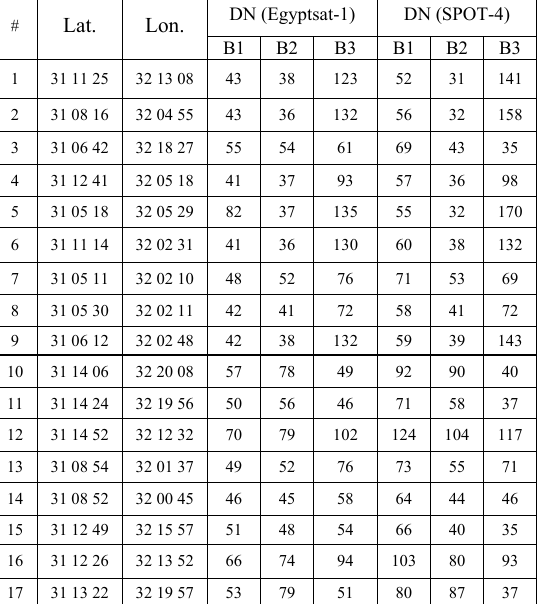
3- To manually calculate the correct calibration coefficients, we have assumed a linear calibration function. The equation of a line relating the two sensor’s output has been determined. We used the standard equation of a line, Y = a X + b, to calculate the calibration coefficients. Therefore, the formula that governs the relation between the digital counts of SPOT-4 and Egyptsat-1 for each equivalent band is indicated by A and B constants in the following equation: BDNADN +⋅= (2) EgyptsatSPOT The following Figures 2, 3, and 4 illustrate Scatter plots of pairs of data values (DN’s) taken by Egyptsat-1sensor readings (X- axis) and Spot-4 readings (Y-axis) for the first three different bands. A relationship between them could be established by fitting a line through the points (linear correlation). Table 3 represents the calculated constants for each band.